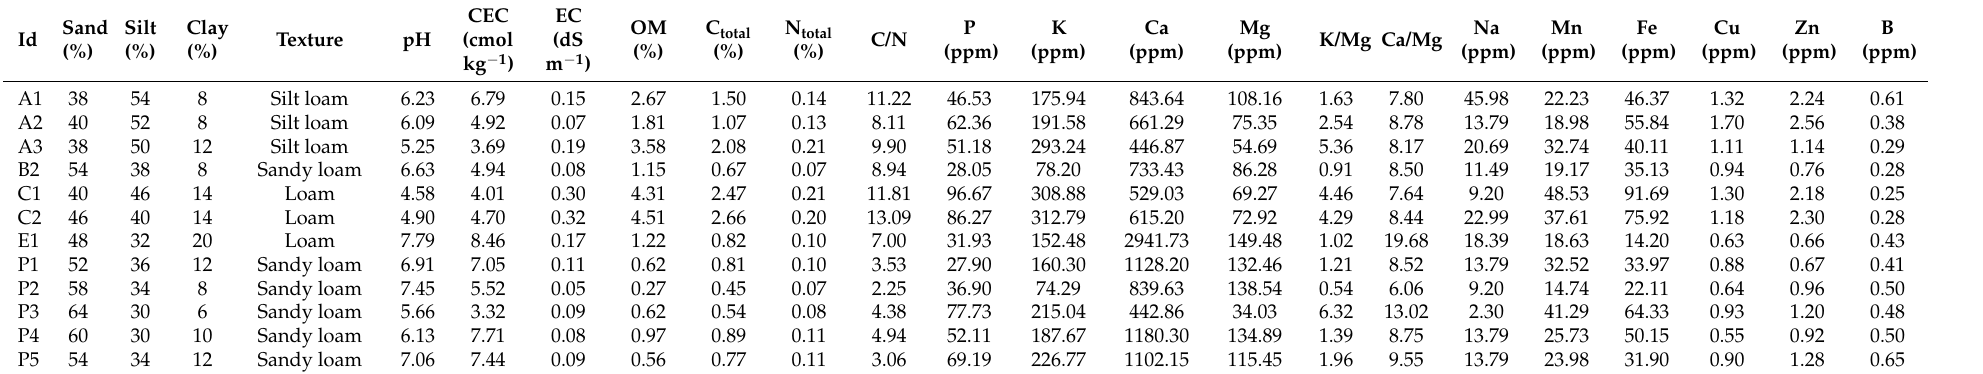
Table 2. Physicochemical characteristics of soil